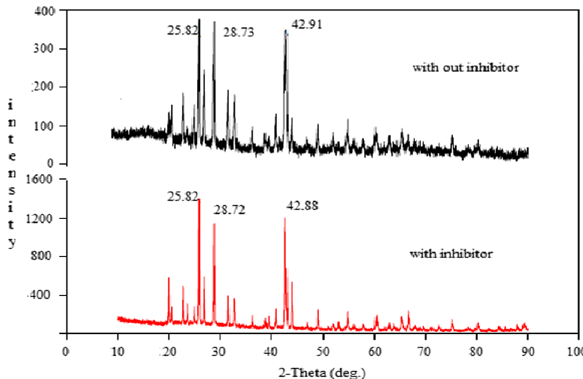
Fig. 10 XRD patterns of BaSO 4 without inhibitor and with inhibitor